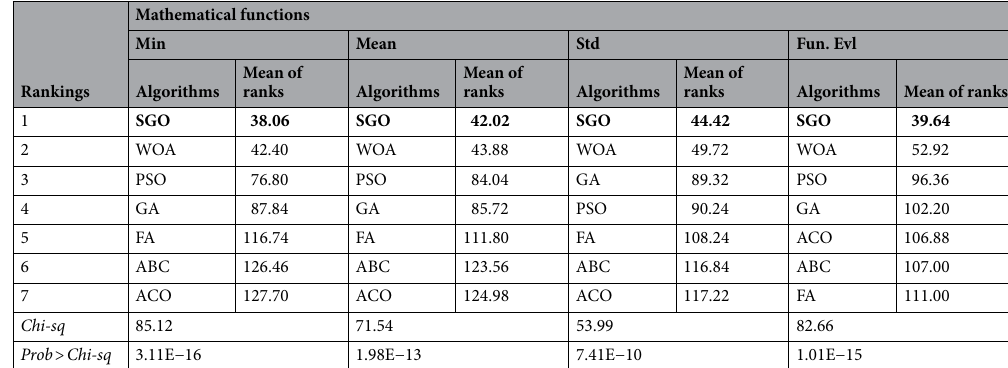
Table 7. The KW test outcomes, including the mean of the ranks regarding mathematical test functions. Significant values are in bold.